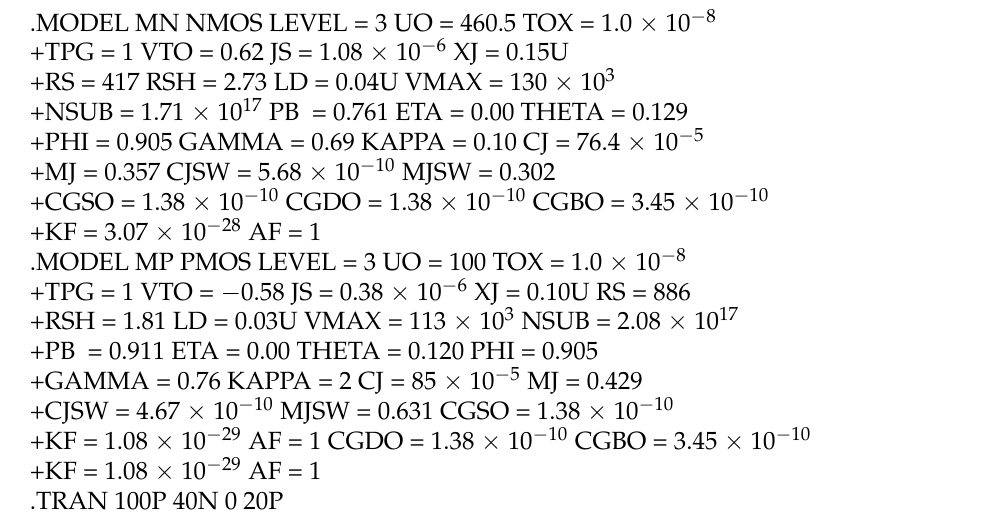
Algorithm 3 Model and Analysis Parameters of Multiplier